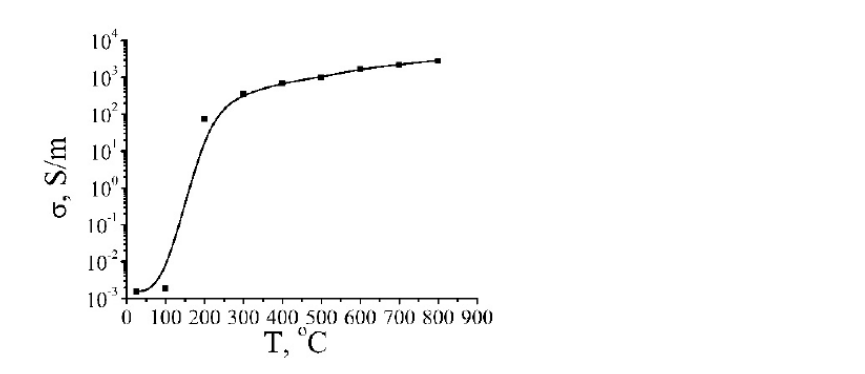
Figure 7. Dependence of the conductivity of reduced GO samples on the annealing temperature. The points have been obtained as a result of averaging over many samples and several magnitudes of the applied voltage [63,64].